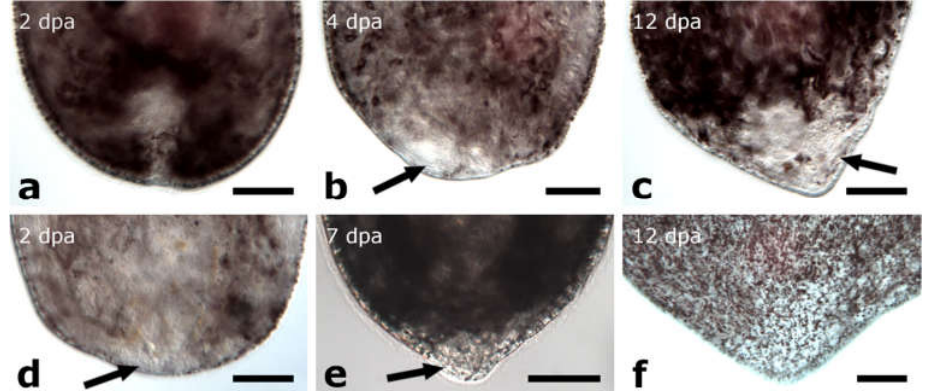
Figure 13. Blastema-like tissue in posterior regenerates of Protomonotresidae sp. After being amputated between brain and pharynx ( a – c ), the wound was fully healed ( a ) and an unpigmented, blastema-like structure was formed at the wound site ( b ). Finally, a new pointy tail tip was built, which was lacking the original pigmentation ( c ). Amputation posterior to the pharynx ( d – f ) After the wound was completely healed, an unpigmented, blastema-like structure was observed at the wound site ( d ). Few days later, the structure was tapered but it was still lacking the original pigmentation ( e ). One week later, also the pigmentation was restored ( f ). Arrows are pointing at the blastema-like tissue. Scale bar is 50 µm.